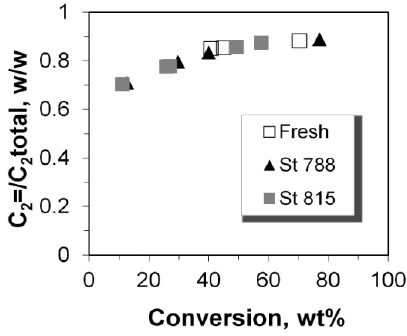
Figure 15. Olefinicity ratio for C 2 products.